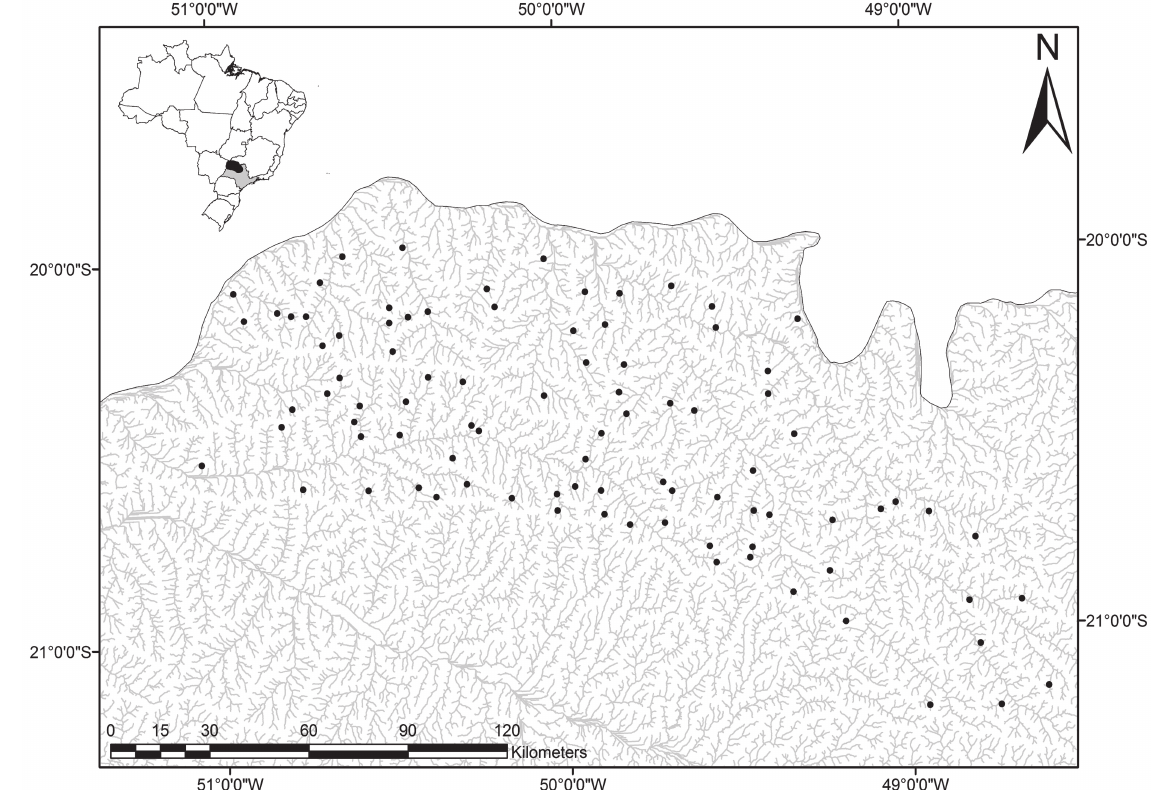
Fig. 1. Location of the study area in the northwestern region of São Paulo State, Brazil (black area on the country map), showing the 91 streams